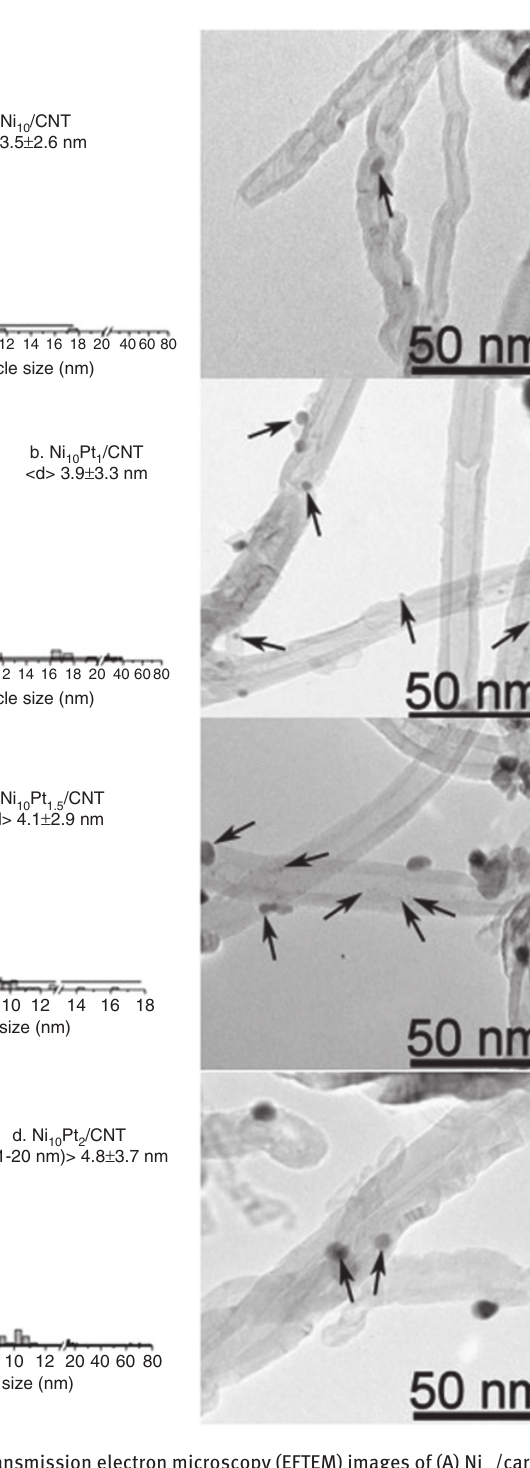
Figure 1: X-ray powder diffraction (XRD) patterns and energy filtered transmission electron microscopy (EFTEM) images of (A) Ni nanotube (CNT), (B) Ni